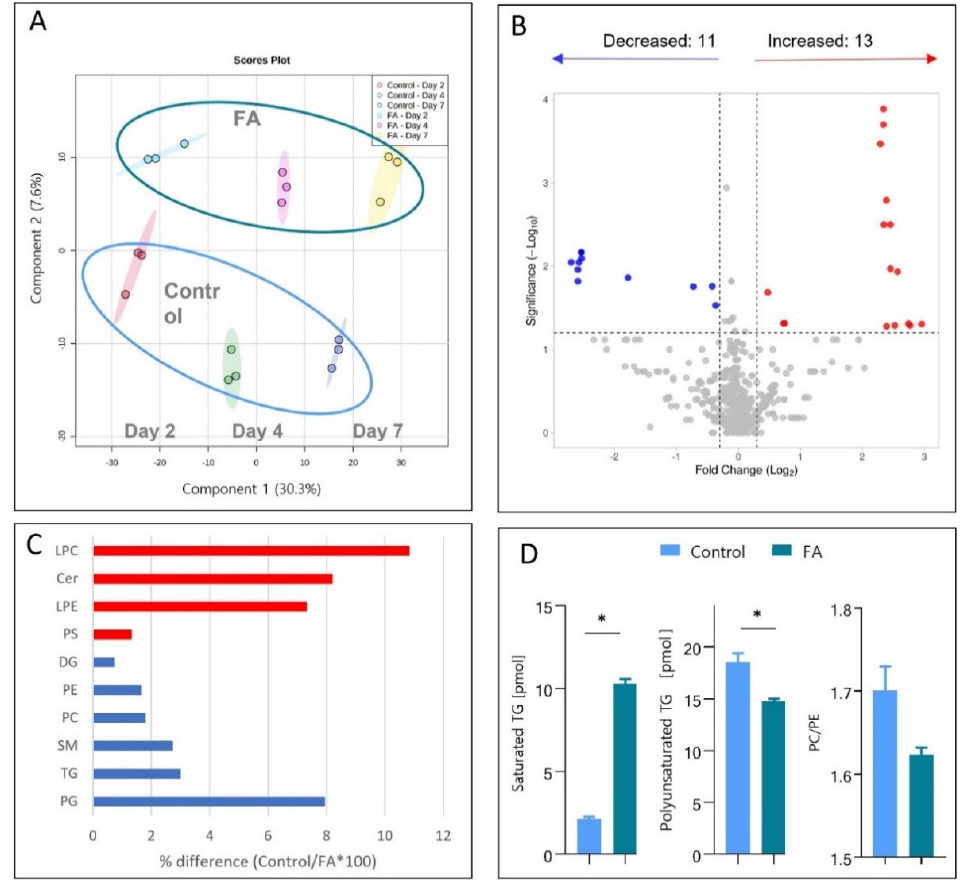
Figure 4. Lipidomics analysis of HepG2/C3A spheroids identifies lipids affected by palmitic and oleic acid treatment. FA-spheroids treated with 45 μM palmitic acid and 65 μM oleic acid, Control-spheroids in standard growth media. ( A ) The partial least square discriminant analysis of samples shows the grouping of Control (blue circle) and FA-treated samples (green circle). ( B ) Volcano plot of the lipid species altered in FA-treated spheroids (7 days) compared to control. The log2 fold change of FA vs. Control was plotted against the -log10 p -value evaluated by t -test. The significance threshold (dotted lines) was p -value < 0.05 and a fold change of 1.5. Dots in red and blue represent significantly decreased and increased species, respectively. ( C ) % difference after 7 days of FA exposure between control and treated spheroids. Red indicates a percentage increase in fatty acid-treated spheroids compared to control displayed in percentage. ( D ) From left, accumulation of saturated triglycerides (TGs) in FA-treated spheroids, decreased levels of polyunsaturated TGs, and decreased PC/PE ratio in FA-treated spheroids as compared to the control samples. * statistically significant difference according to Student’s t -test and Holm–Sidak post hoc test, p < 0.05, n = 3. Error bars show